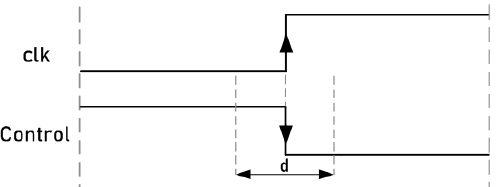
Figure 10. Representation of control signal